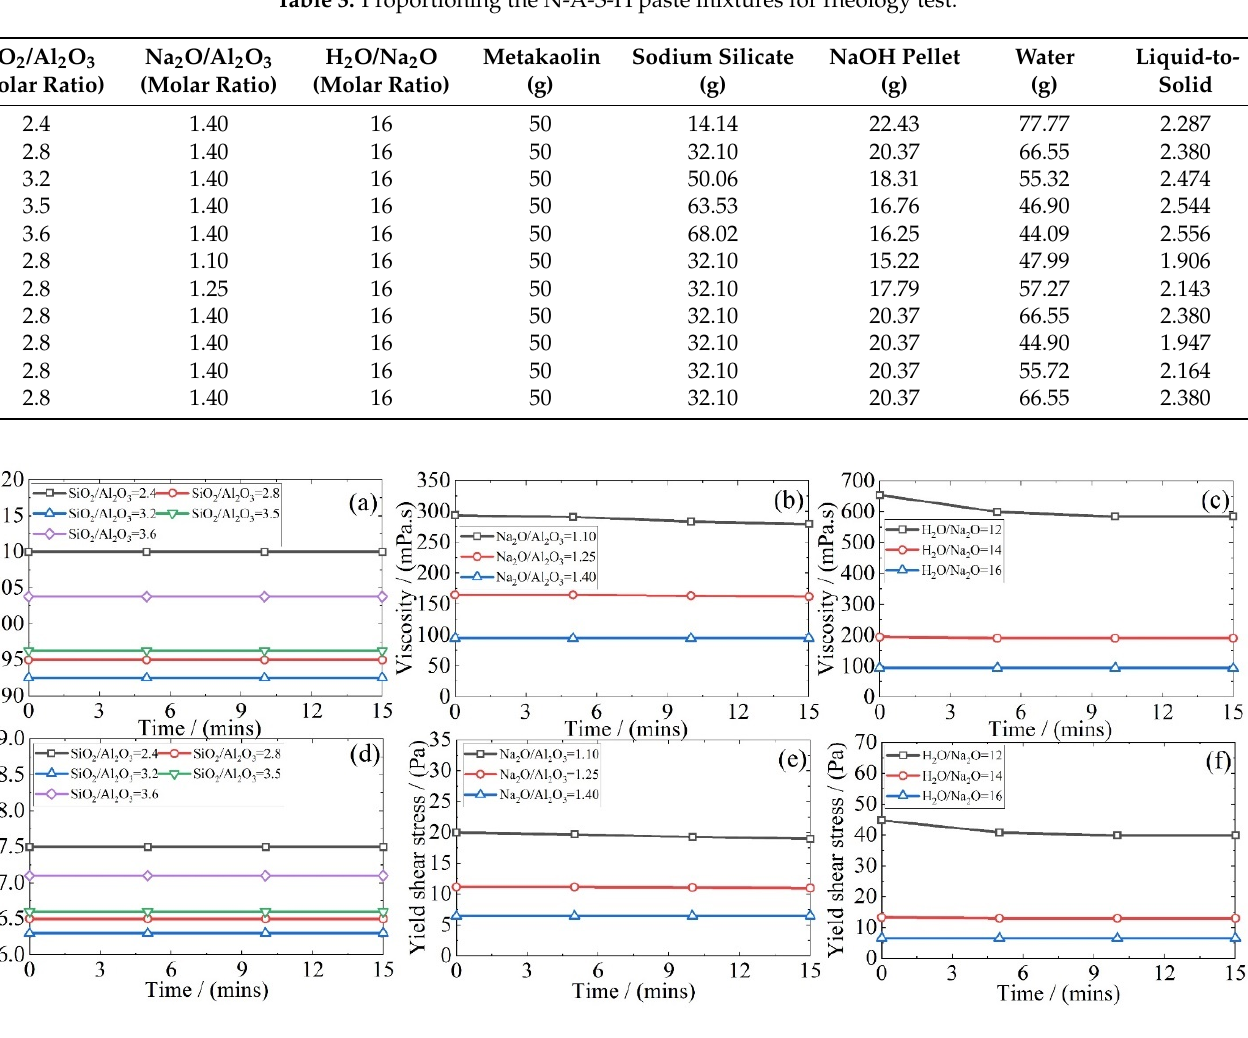
Table 3. Proportioning the N-A-S-H paste mixtures for rheology test.